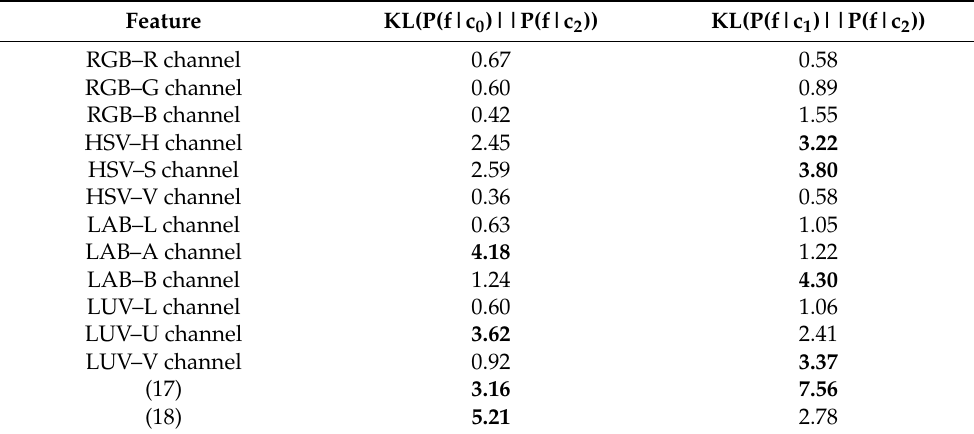
Table 1. KL divergence of color